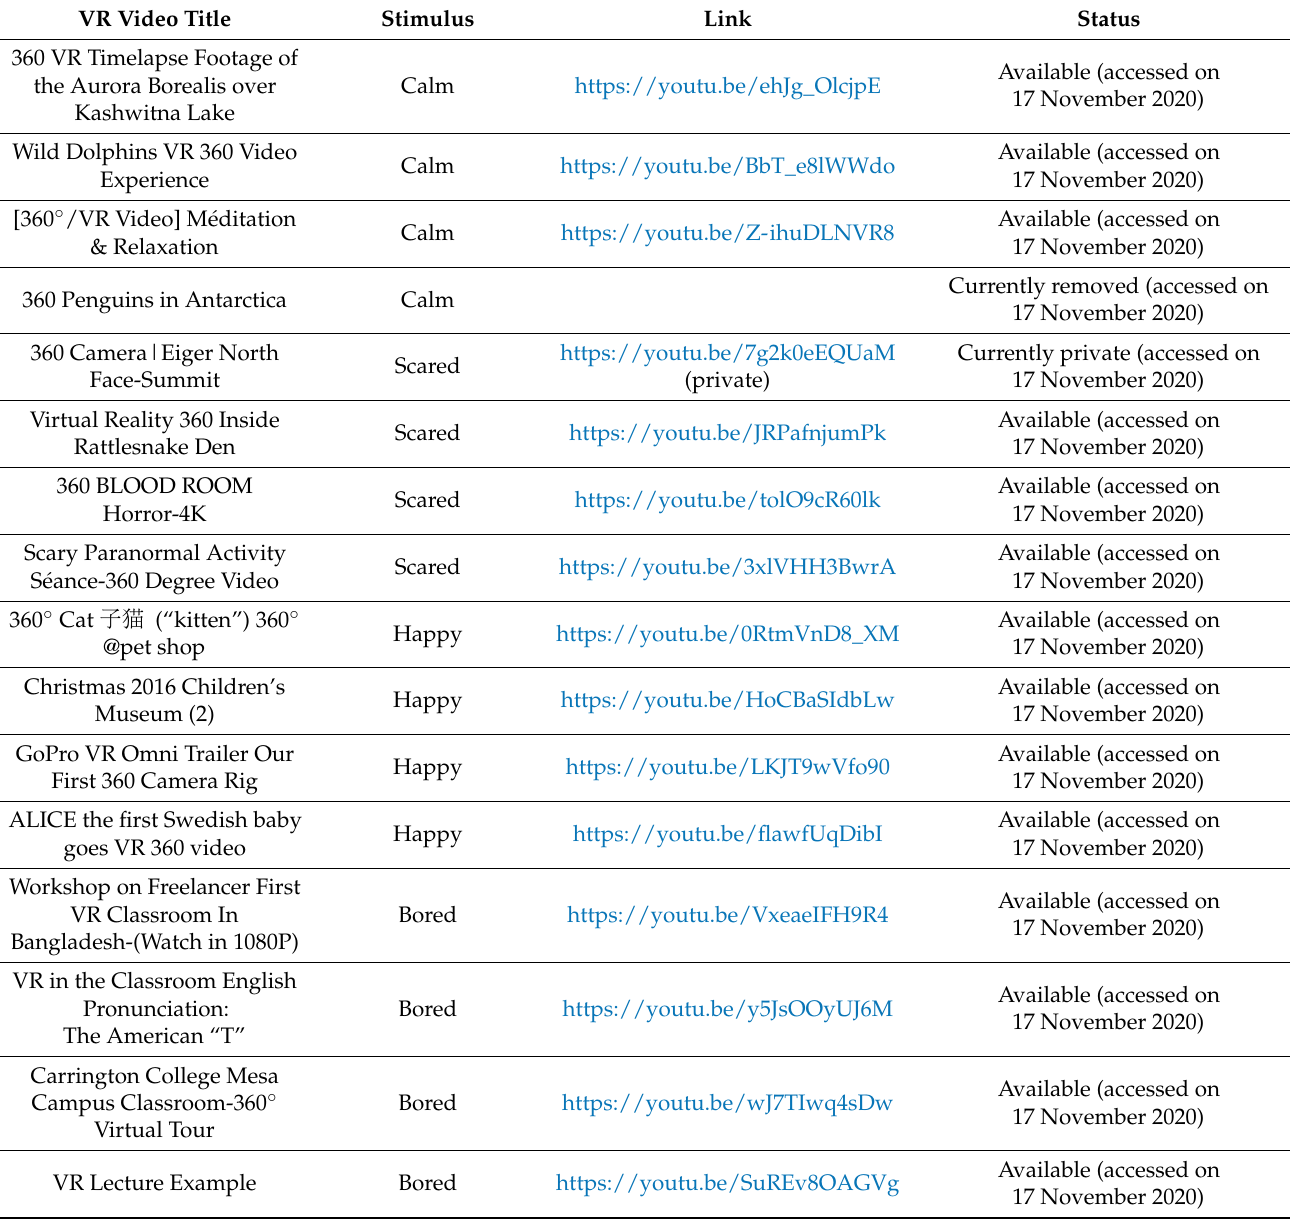
Table 3. VR videos used for stimulating emotional